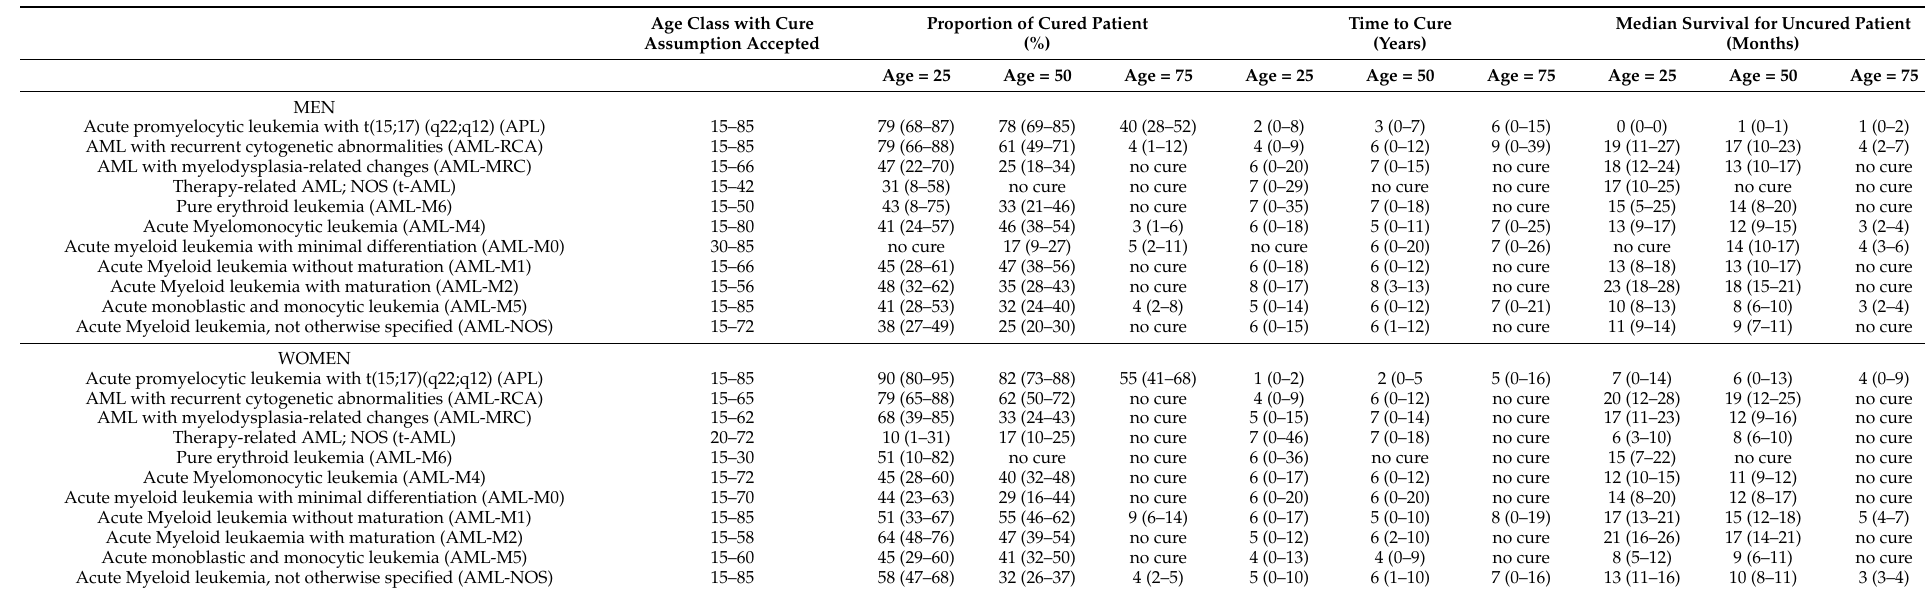
Table 4. Estimated Proportion of cured patient in percent, Time to cure in years and Median survival for ‘uncured’ patient (and 95% Confidence Interval) when cure assumption was acceptable, according to AML-subtype and sex for all age and with age fixed at 25, 50 and 75 years old. Results of the flexible cure model retained in each AML-subtype and sex with the covariate age at diagnosis fixed to the value equal to 25, 50 and 75 years